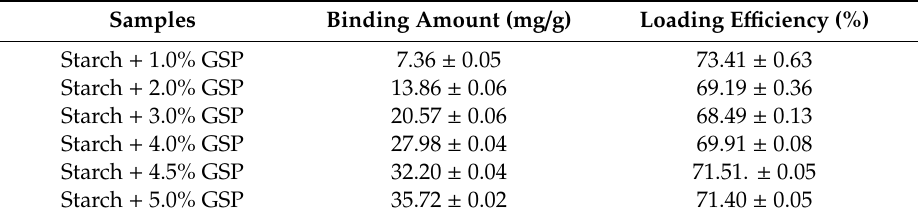
Table 1. Amount of grape seed proanthocyanidins that reacted with potato starch in aqueous ethanol solutions.